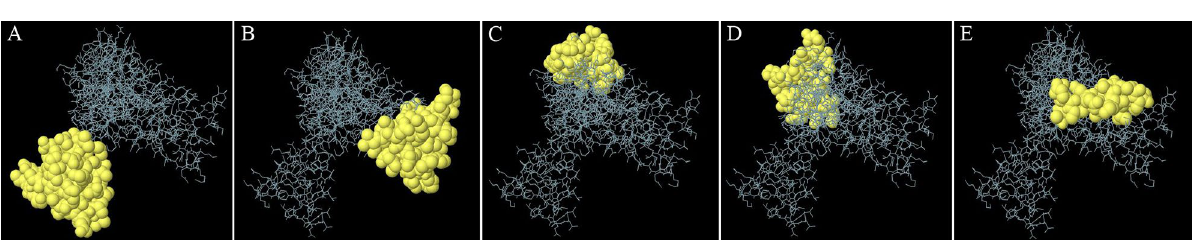
Figure 7. To visualize discontinuous epitopes on the vaccine construct’s 3D structure ( A – E ), the open- source molecular viewer Jmol (http:// jmol. sourc eforge. net/) was employed. The gray sticks and the yellow surface indicate the vaccine construct and discontinuous B-cell epitopes, respectively.